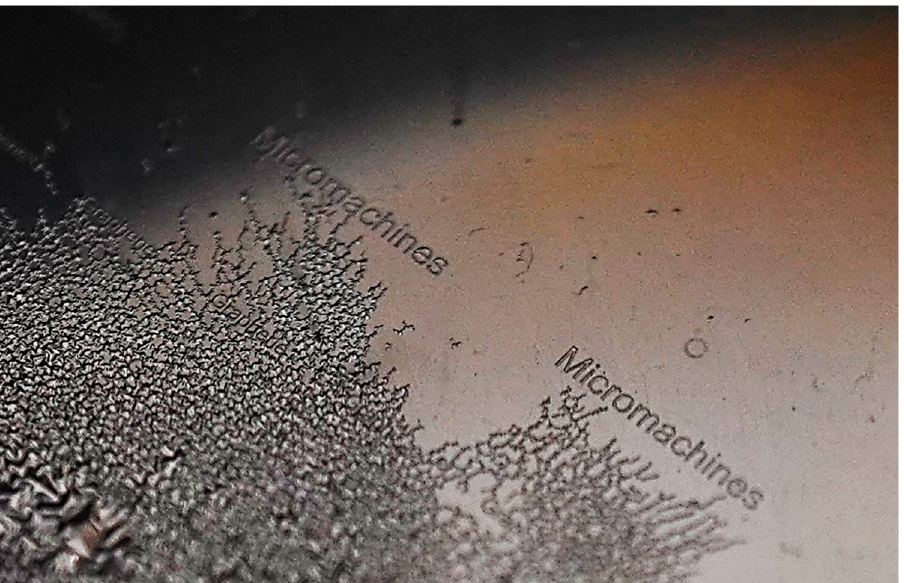
Figure 4. Optical image of the cracks generated directly after dipping the wafer in acetone, after copper deposition. The full Cu film peels off from the substrate and the rGO under the Cu film is detached with it from the COC substrate.